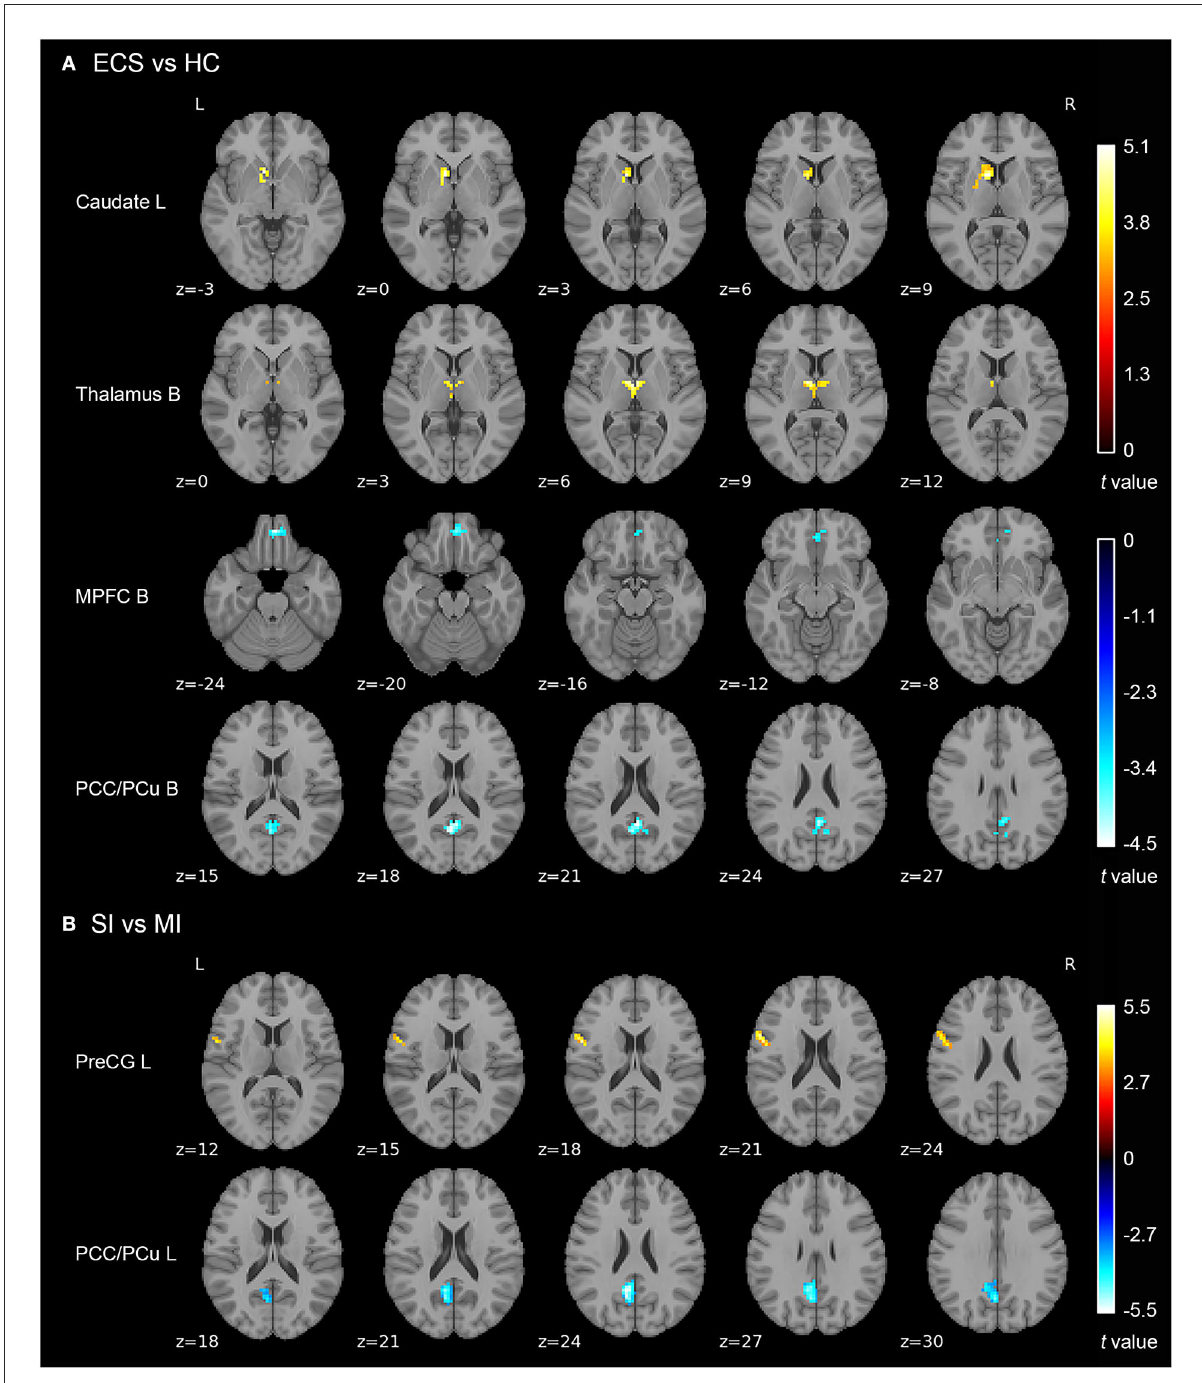
FIGURE2 ALFF differences in ECS, HCs, and ECS cognitive subtypes (SI and MI). (A) Abnormal ALFF in ECS relative to HCs. (B) Increased ALFF in left PreCG and decreased ALFF in left PCC/PCu in SI relative to MI. Results were cluster-wise FWE corrected. Abbreviations: ALFF, amplitude of low-frequency fluctuations; ECS, early course schizophrenia; SI, severely impaired subtype; MI, moderately impaired subtype; HC, healthy control; MPFC, medial prefrontal cortex; PCC/PCu, posterior cingulate cortex/precuneus; PreCG, precentral gyrus; L, left; B, bilateral; FWE, family-wise